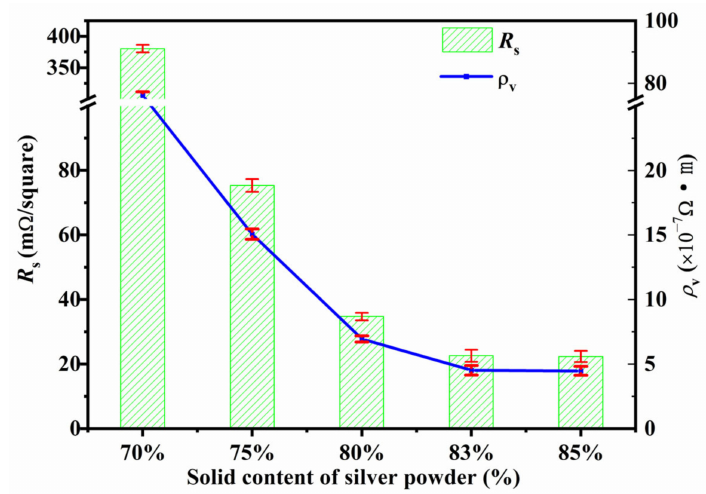
Figure 6. The R s and ρ v of cured silver pastes with different silver content.